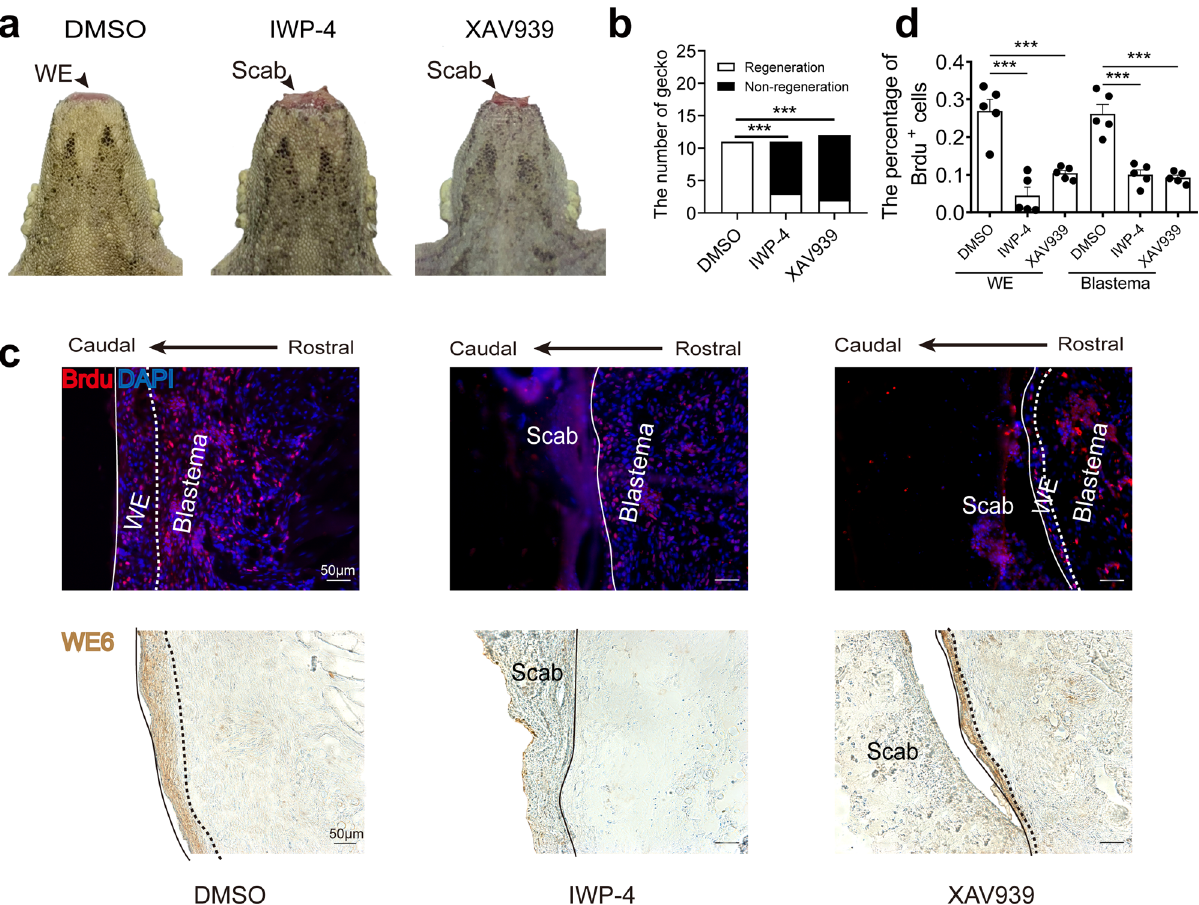
Fig. 4 Wnt inhibition decreased the proliferation of wound epithelium. a Formation of wound epithelium (WE) in control (DMSO) and Wnt inhibition groups (IWP-4 and XAV939). b Number of geckos with regeneration in control and Wnt inhibition groups. N = 10. c Immuno fl uorescence analysis of BrdU staining in control and Wnt inhibition groups (upper panel). Immunohistochemical analysis of WE6 staining in the same location of the samples. Solid line indicates the caudal border of wound epithelium, dotted line indicates border between wound epithelium and blastema. Scale bar = 50 µ m. d Number of BrdU positive cells in control and Wnt inhibition groups. Values represent mean ± SD, N = 5, ns p > 0.05, * p < 0.05, ** p < 0.01, *** p <